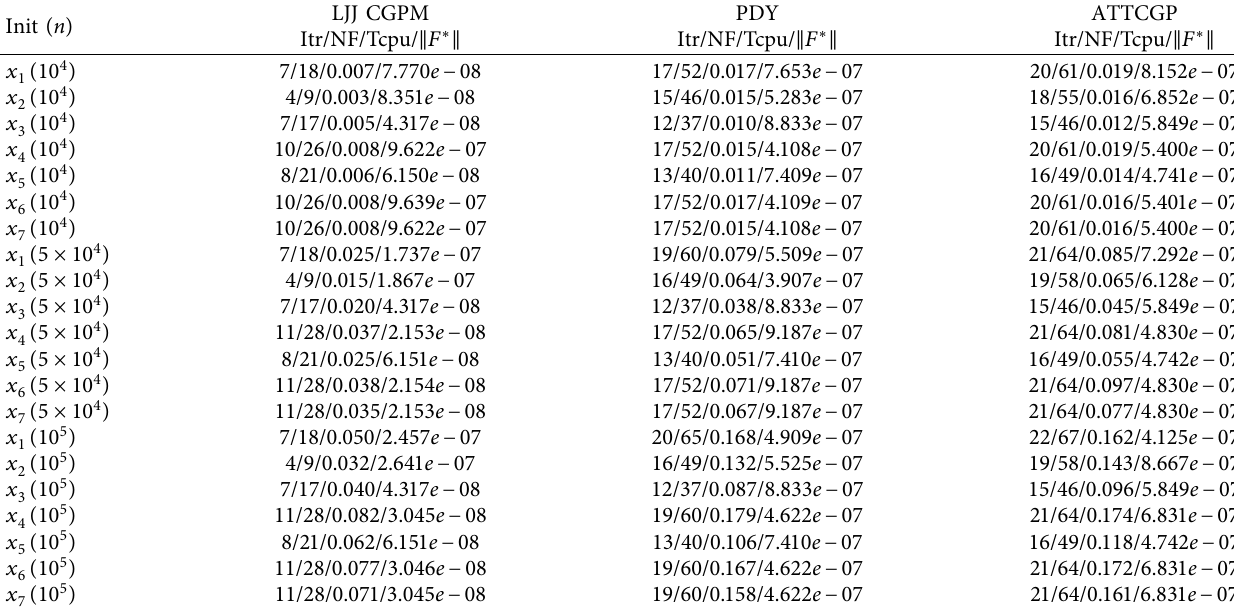
Table 4: Numerical results on Problem 4.